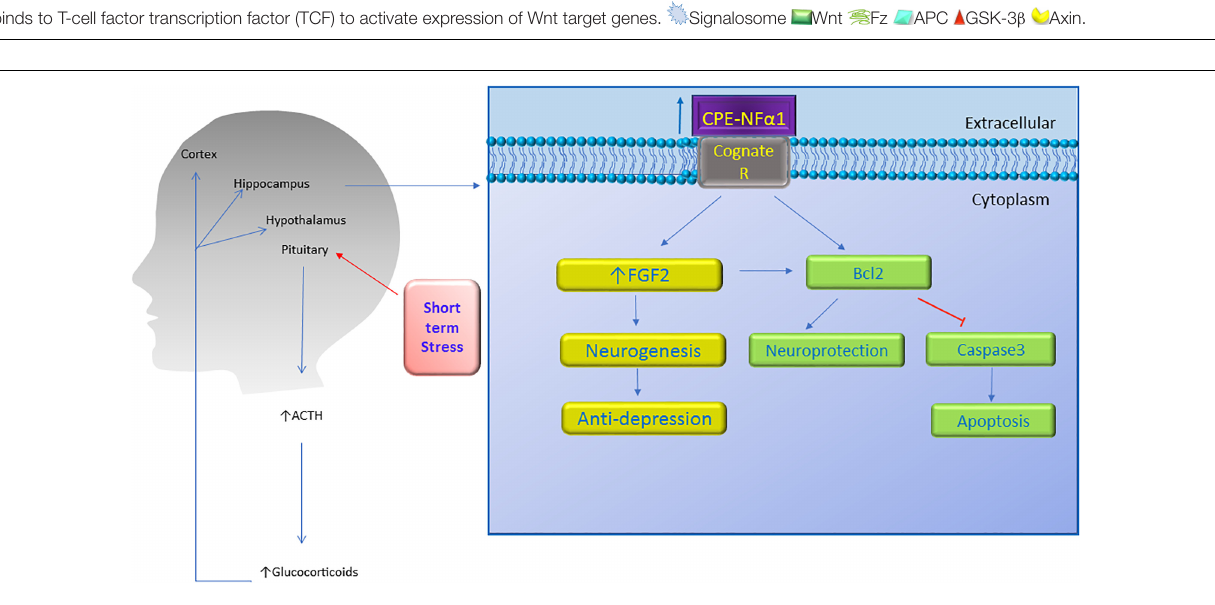
FIGURE 4 | Neuroprotective effect of CPE-NF α 1. Short term stress activates the hypothalamic-pituitary-adrenal axis which then increases ACTH and glucocorticoid secretion. The glucocorticoids upregulate CPE-NF α 1 expression via glucocorticoid regulatory elements (GRE) on the promoter. CPE-NF α 1 is secreted and possibly activates its cognate receptor which then produces antidepressant-like effects via increasing FGF2 expression and neurogenesis in the hippocampus. Additionally, CPE-NF α 1 protects against neurodegeneration through upregulating Bcl2, a mitochondrial pro-survival protein, by inhibiting caspase 3-mediated